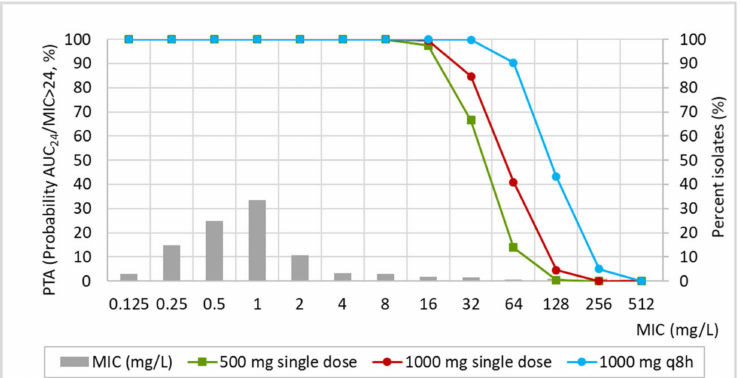
Figure 4. Probability of target attainment (PTA) for fosfomycin and MIC distribution of E. coli against fosfomycin reported by